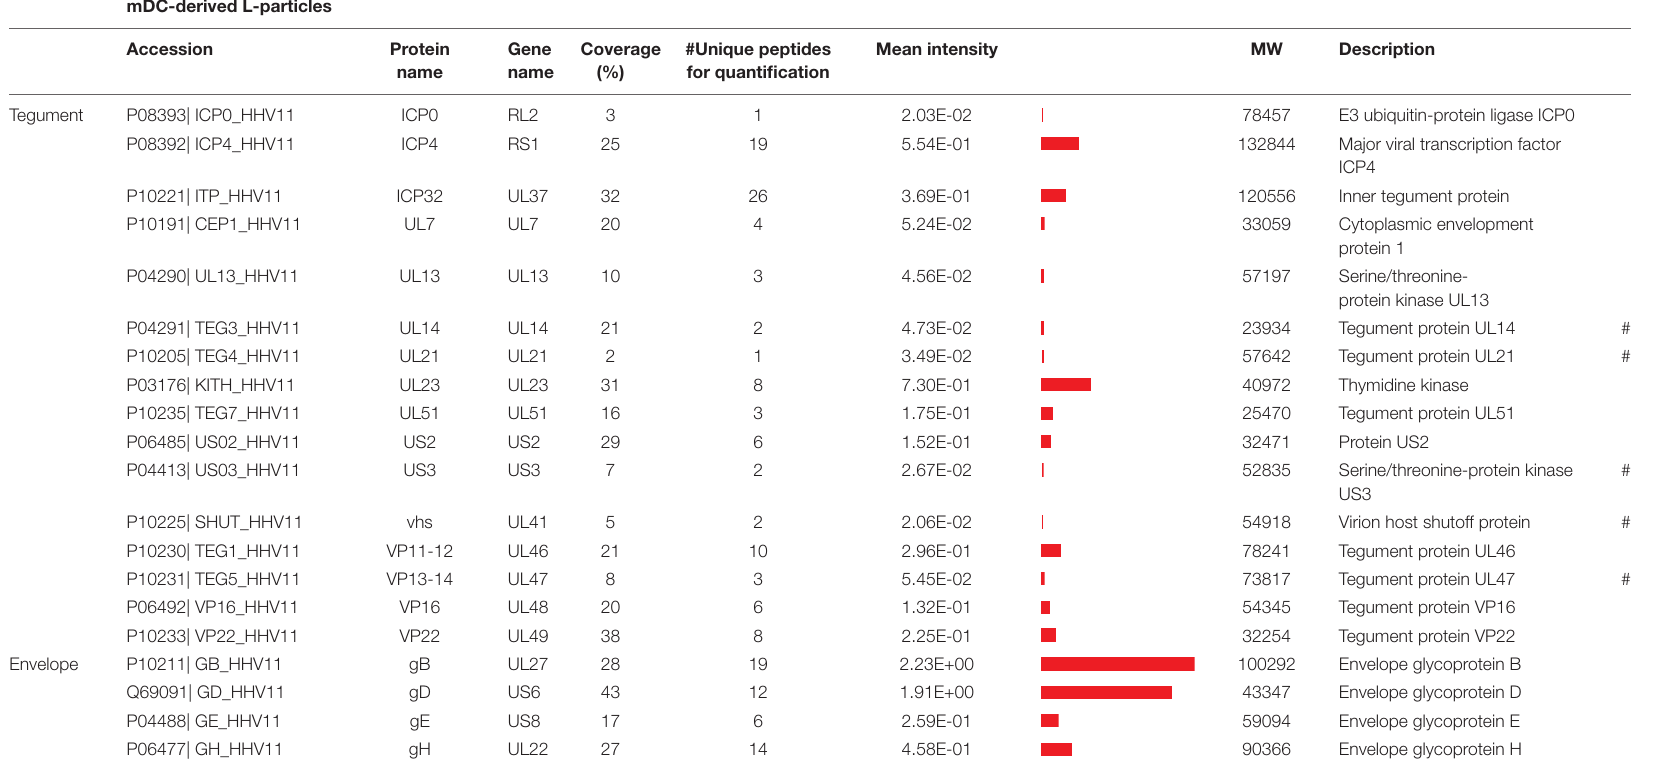
TABLE 1 | Mass spectrometric identification of viral proteins in L-particles derived from HSV-1-infected